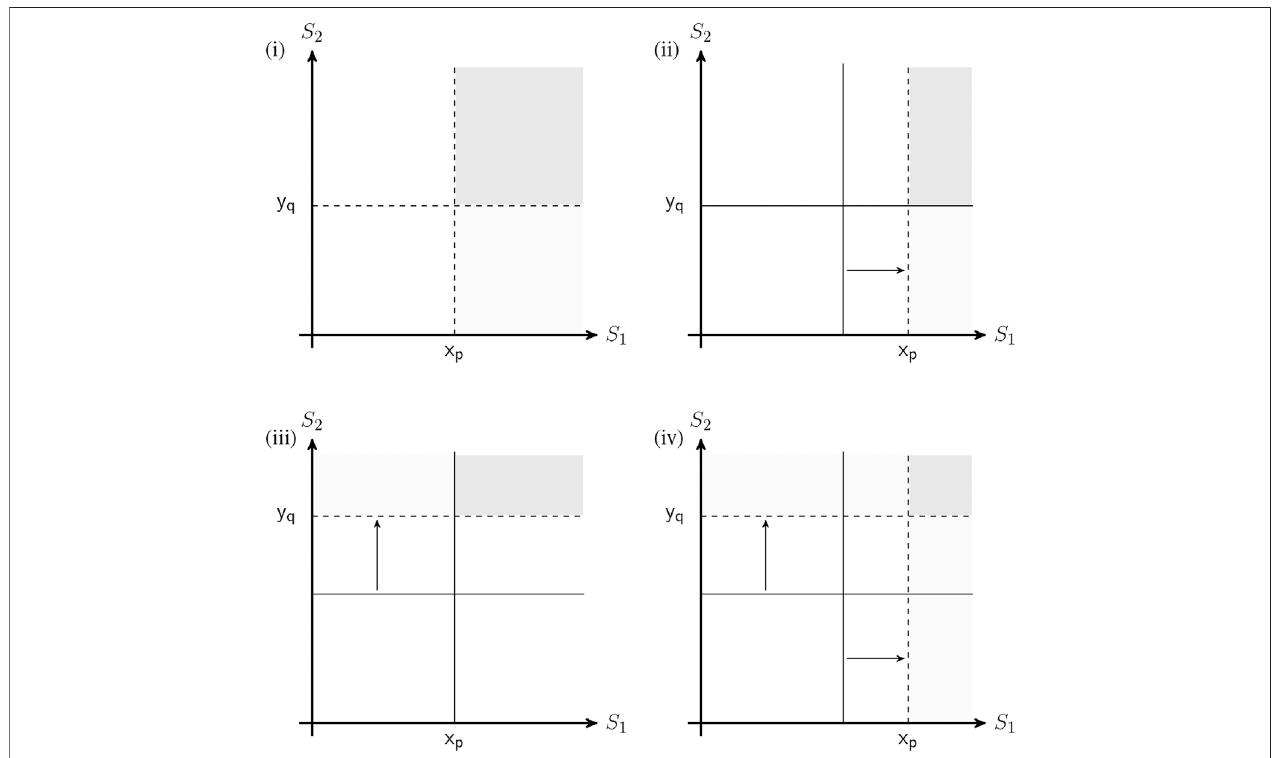
FIGURE 1 | Exemplary quantile partitions and assessments of upper tail service time